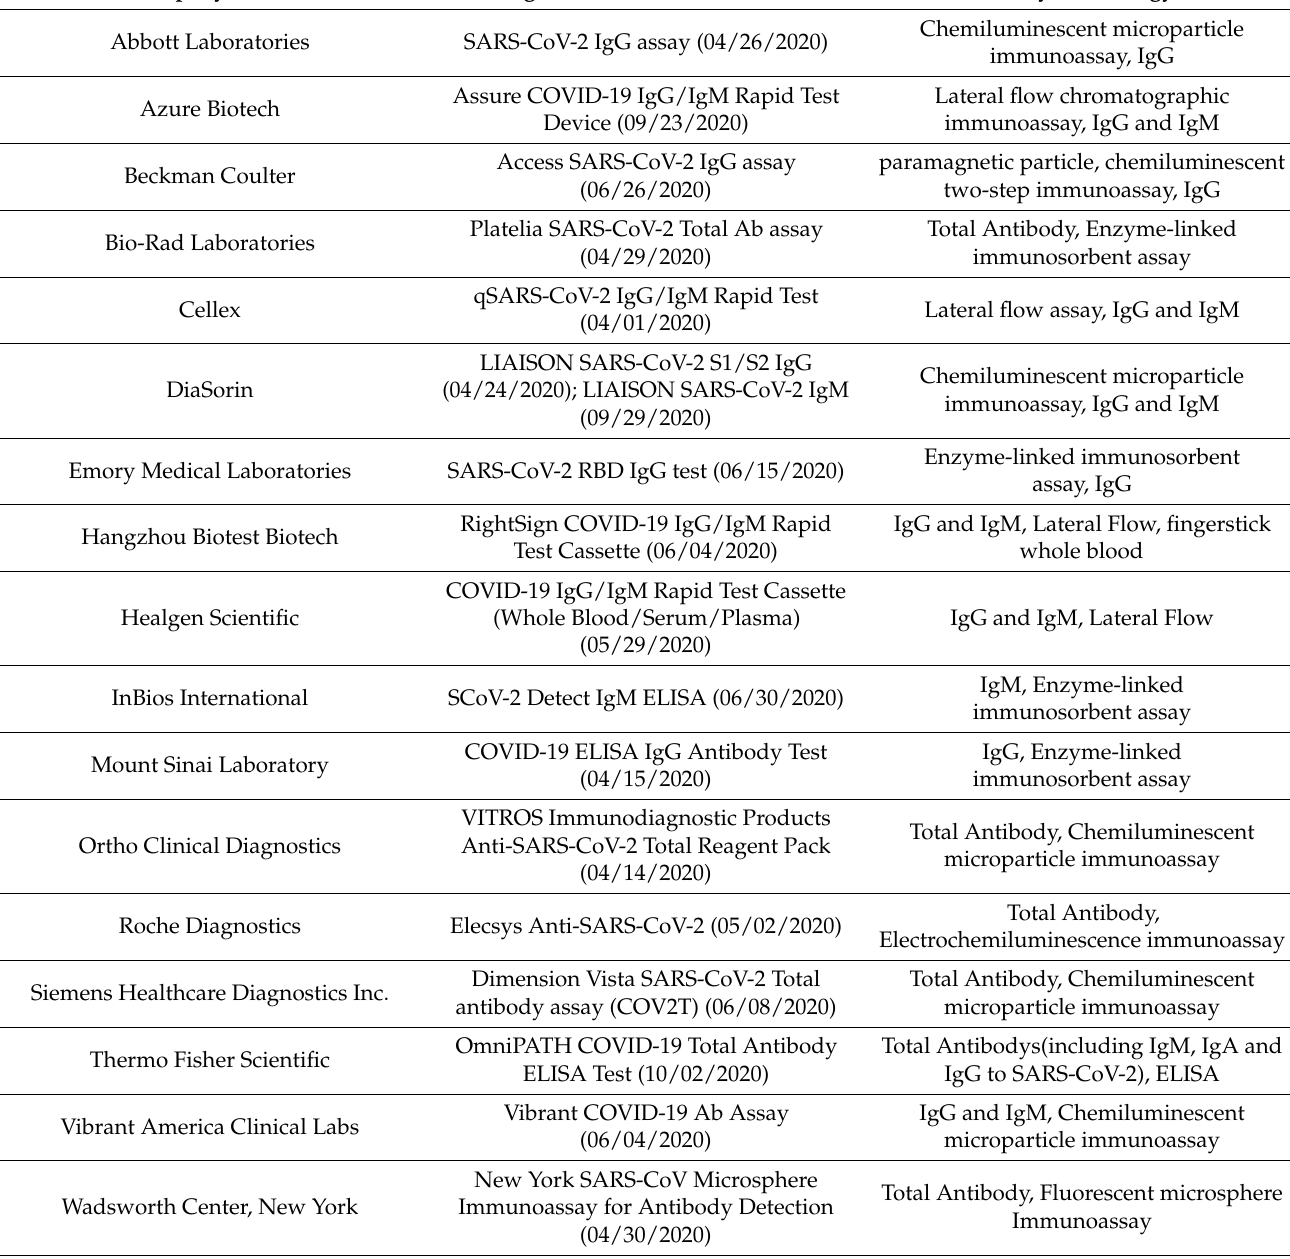
Table 4. Serology or Antibody Tests granted FDA Emergency Use